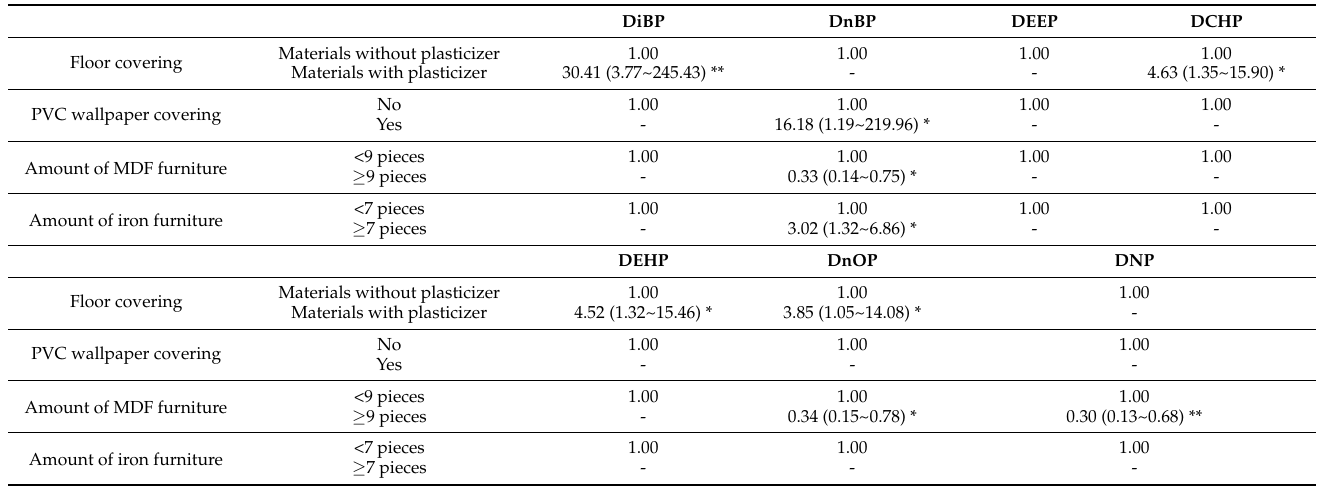
Table 4. Results of multivariate logistic regression analysis between decorating materials and phtha- late concentrations (95% confidence interval).